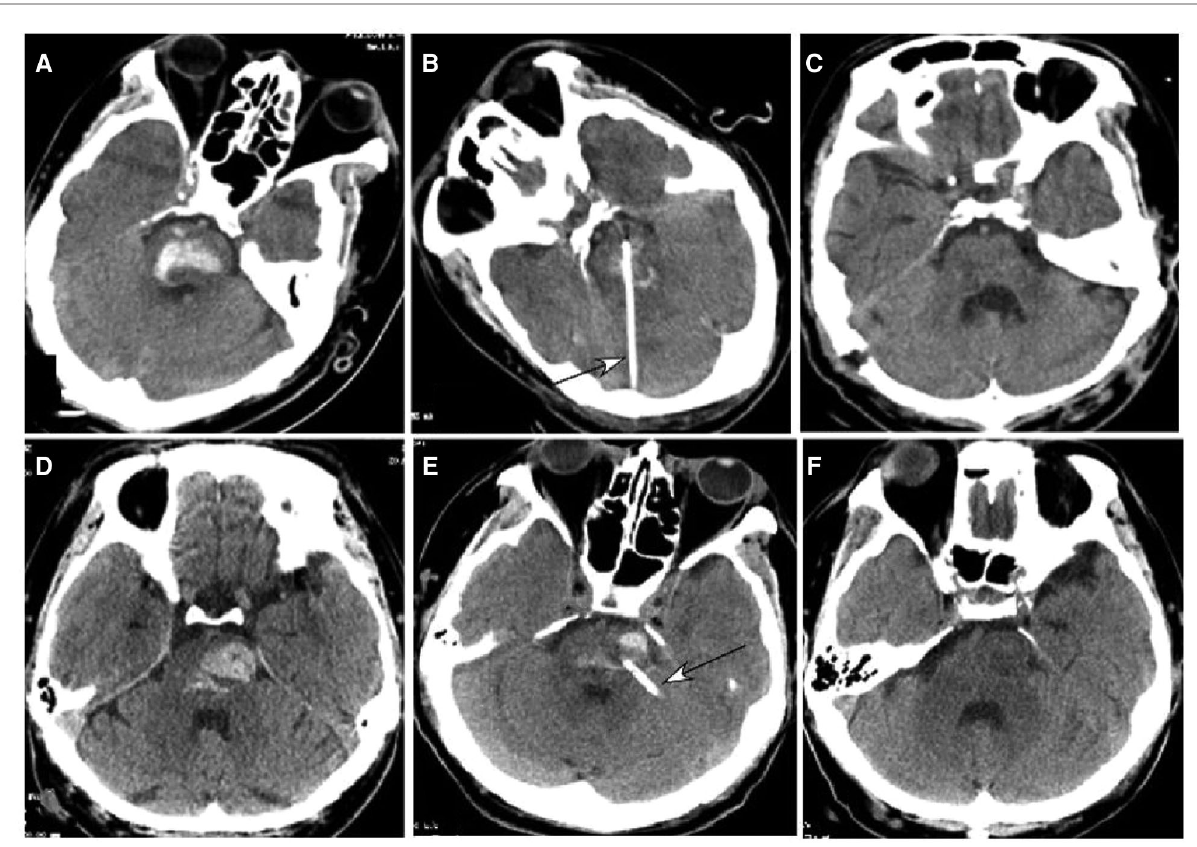
FIGURE 2 Brainstem hemorrhage. ( A – C ) A 52-year-old man had a sudden loss of consciousness 5 h before presentation. Before surgery, he was in a coma with a Glasgow Coma Scale (GCS) score of 5 (E1VTM4) supported with mechanical ventilation. ( A ) Computed tomography (CT) revealed